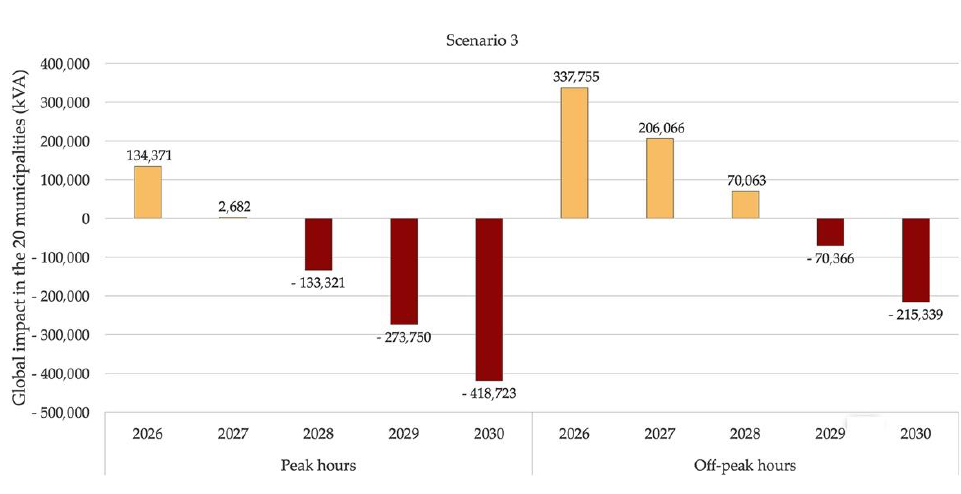
Figure 6. Global impacts for the municipalities during peak and off-peak hours, 2026 – 2030.